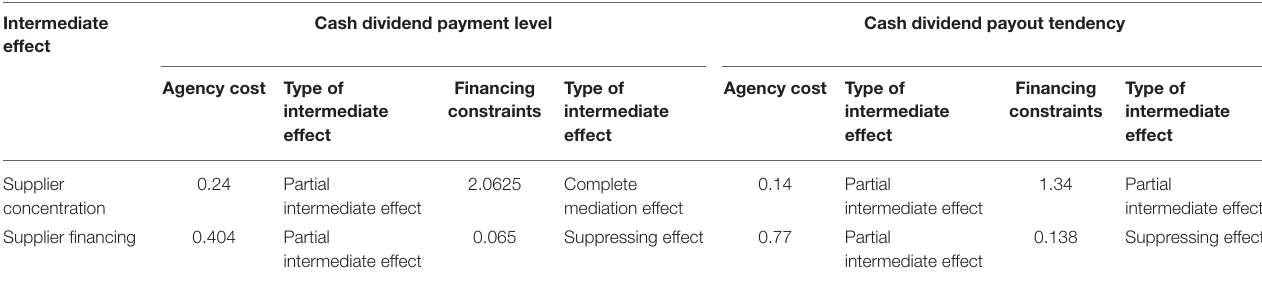
TABLE 8 | Results of intermediary effect between supplier relationship strategy and cash dividend: Intermediary effect of agency cost and financing